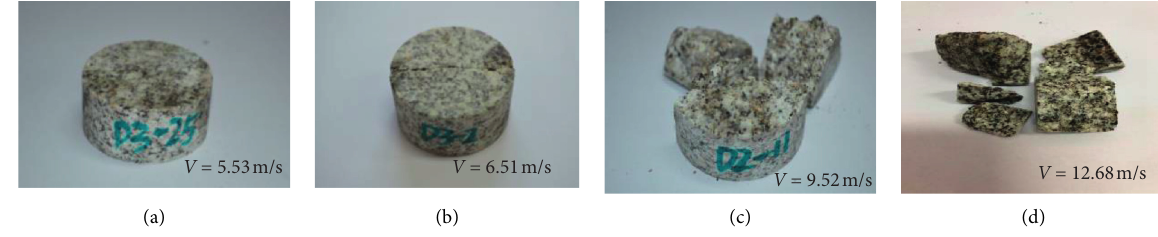
Figure 5: Failure mode of different impact velocity. (a) Intact. (b) Fractured. (c) Cracked. (d) Broken.